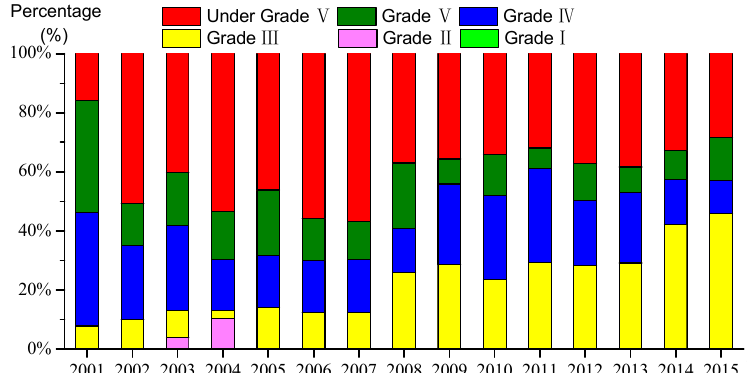
Figure 6. Water quality of inland rivers in Shanghai from 2001 to 2015.